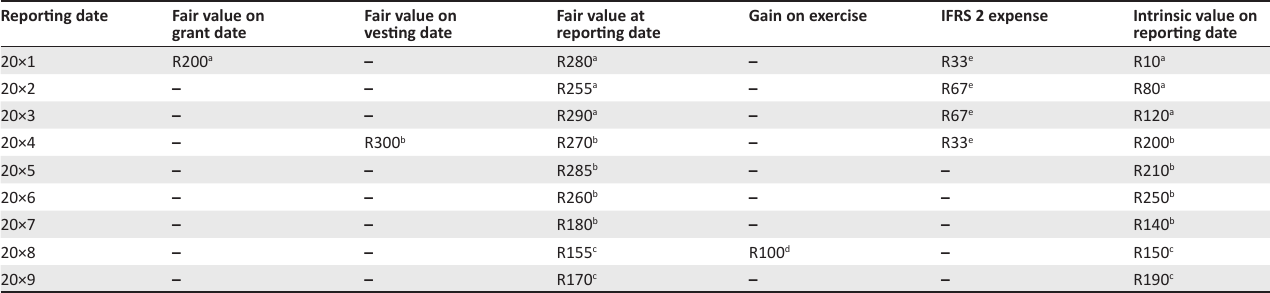
TABLE 7: Disclosures of share-based payment ‘value’, per director, in the 20 x 1 to 20 x 9 financial statements of Company X. Reporting